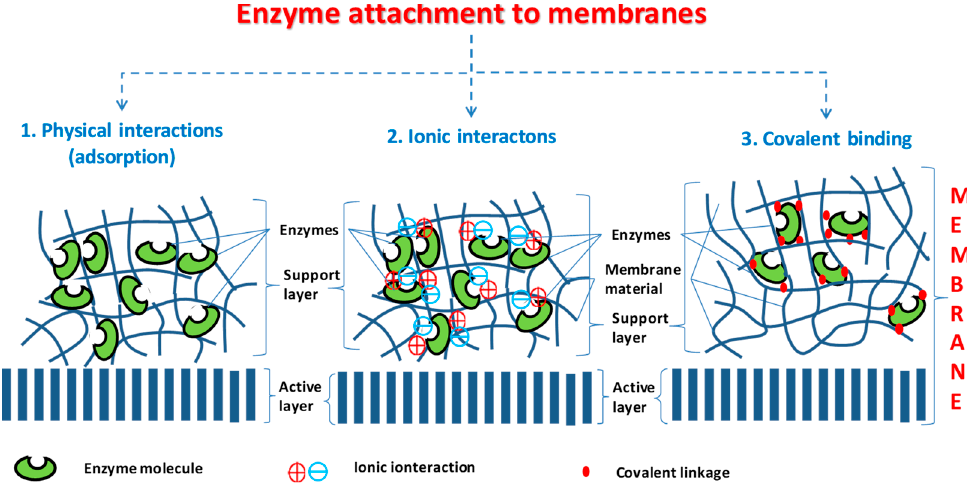
Figure 2. Three main types of enzyme attachment to membrane: ( 1 ) enzyme immobilization by physical interaction (adsorption), ( 2 ) enzyme immobilization by ionic linkage (electrostatic interaction), ( 3 ) enzyme immobilization by covalent linkage between enzyme molecules and molecules of the support material (e.g., polymer chains) of the membrane.